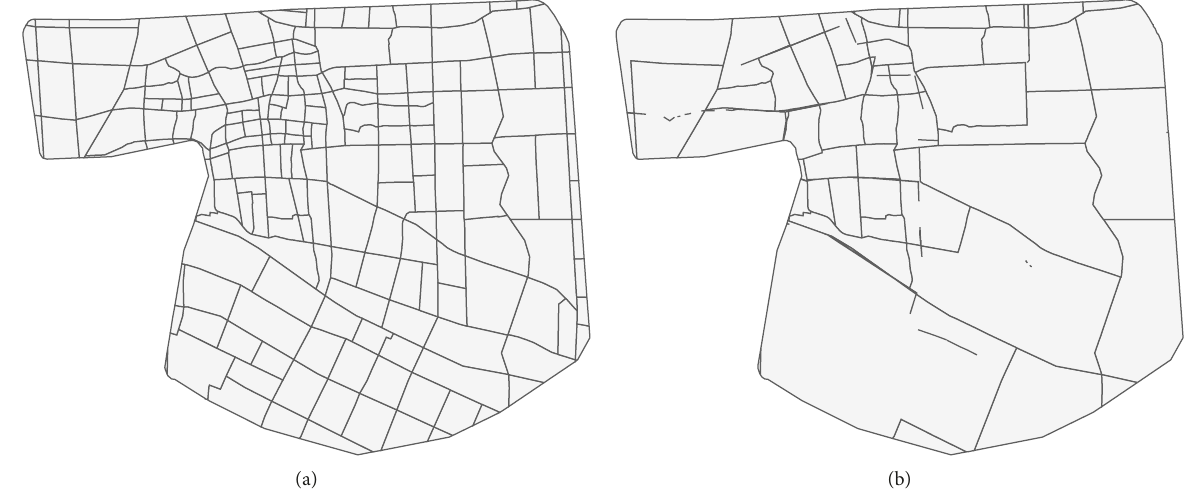
Figure 5: (a) TAZ and (b) CT spatial units of the studied